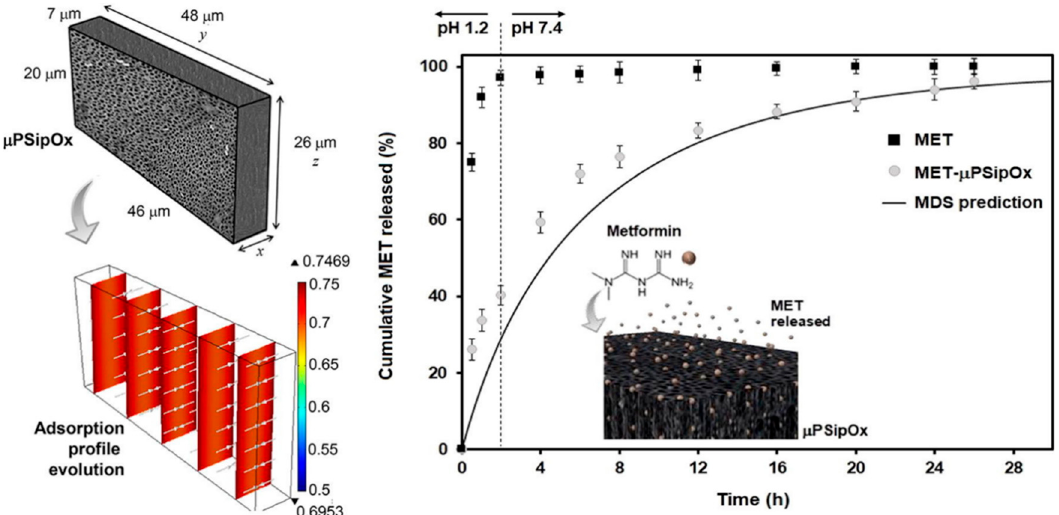
Figure 7. Representative geometry used for modelling the loading kinetics during the adsorption of metformin (MET) onto porous silicon microparticles ( μ pSip), dimensionless concentration profiles inside the μ pSipOx during the adsorption of MET, and in vitro release profiles of pure MET and MET- μ pSipOx (oxidised porous silicon microparticles). Reproduced with permission from [126].